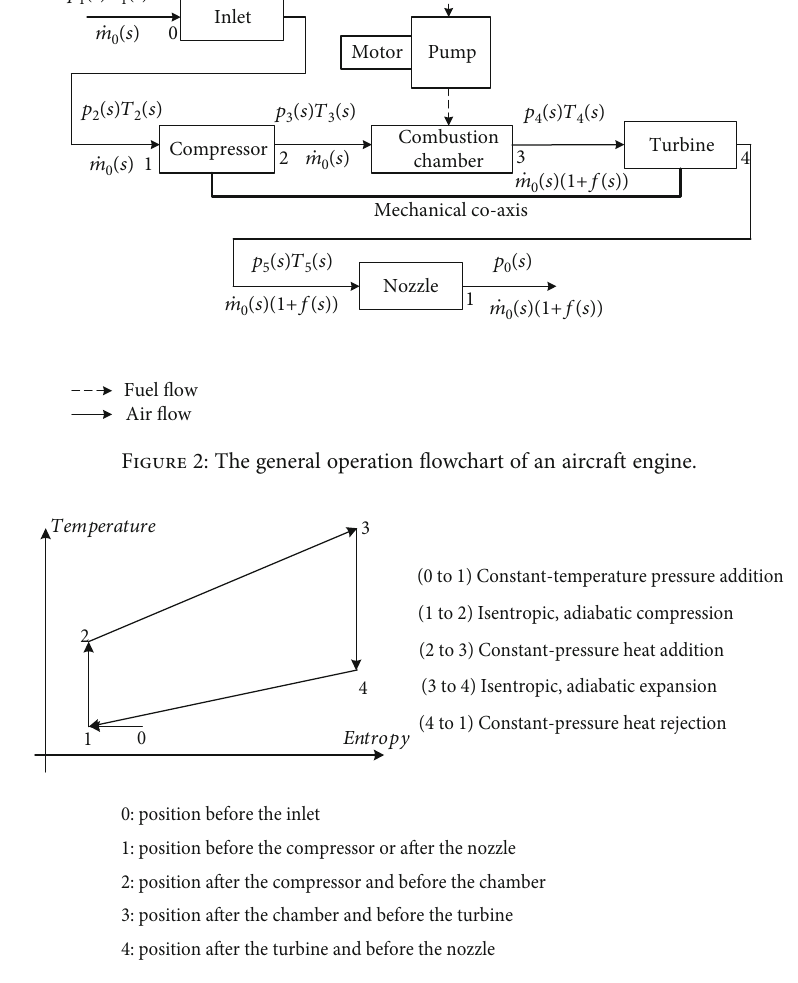
Figure 3: The Brayton cycle for an aircraft